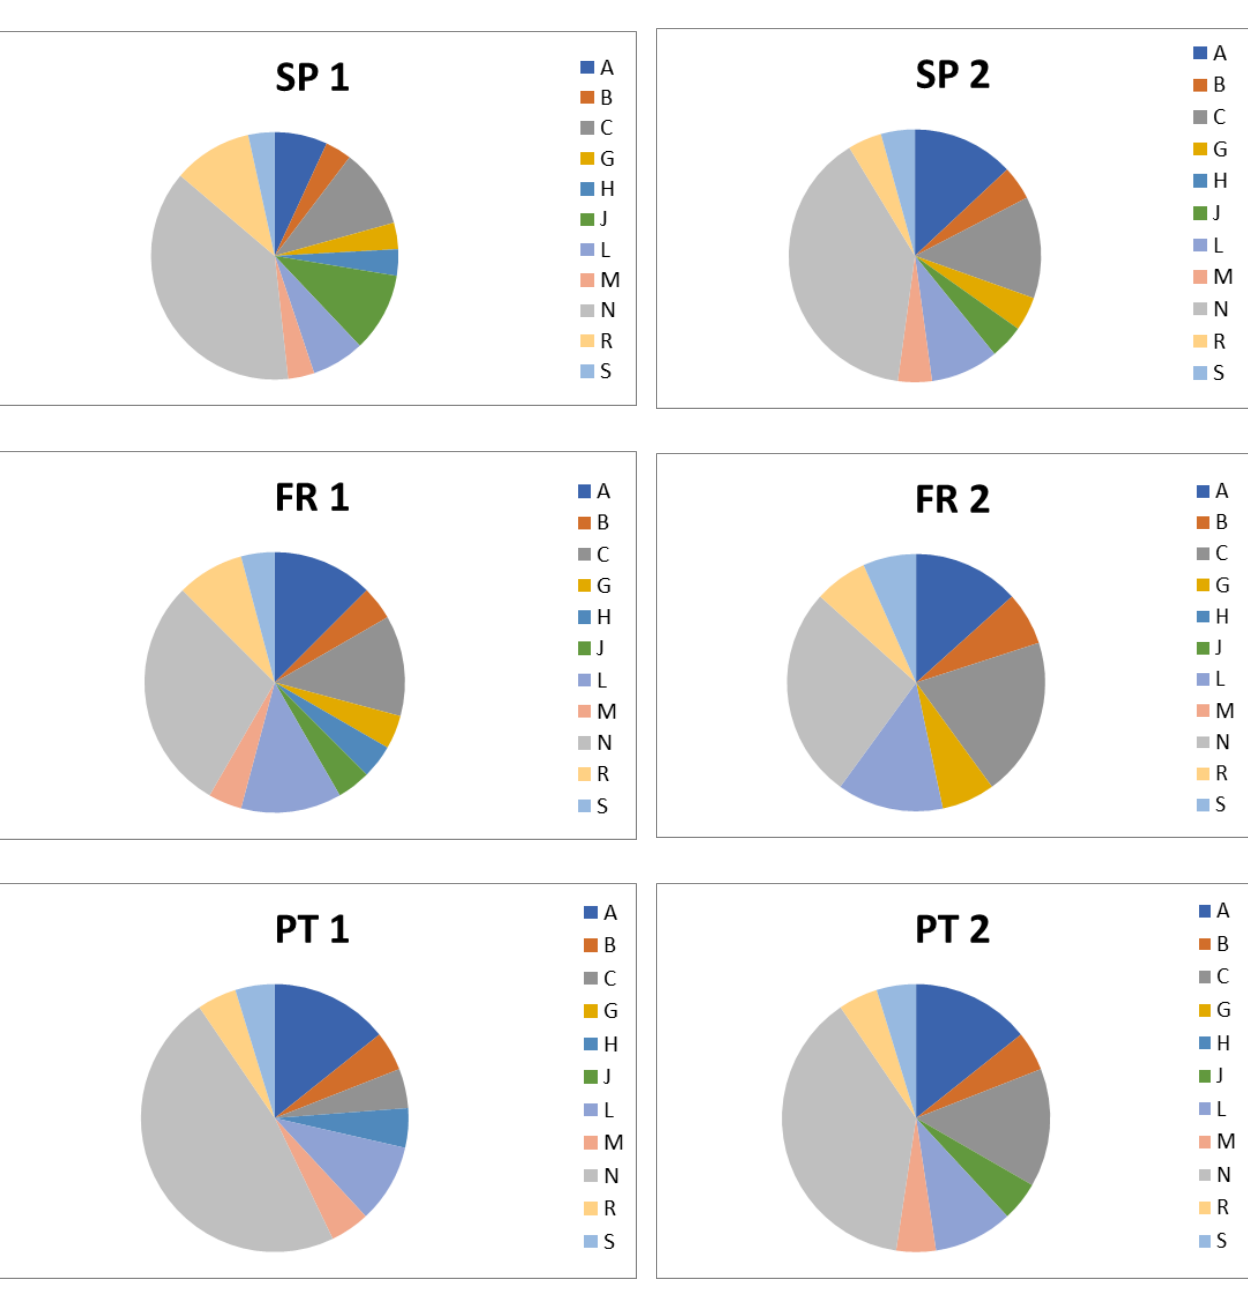
Figure 3. Profile of pharmaceuticals detected in each residence according to the ATC code: A = Alimentary tract and metabolism; B = Blood and blood forming organs; C = Cardiovascular system; G = Genito urinary system and sex hormones; H = Systemic hormonal preparations, excl. Sex hormones and insulins; J = Antiinfectives for systemic use; L = Antineoplastic and immunomodulating agents; M = Musculo-skeletal system, others; N = Nervous system; R = Respiratory system; S = Sensory organs.